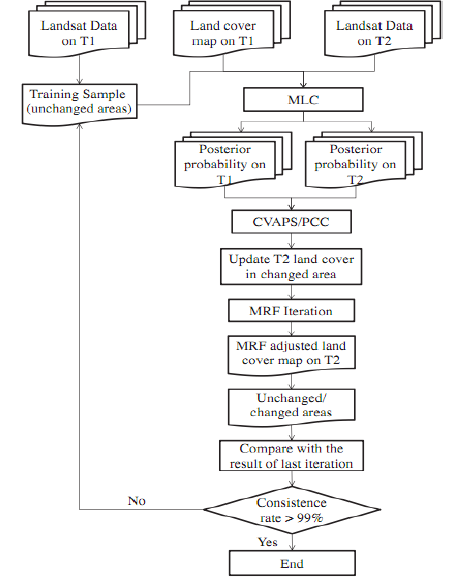
Figure 2.Flowchart of the proposed approach (Chen et al.,